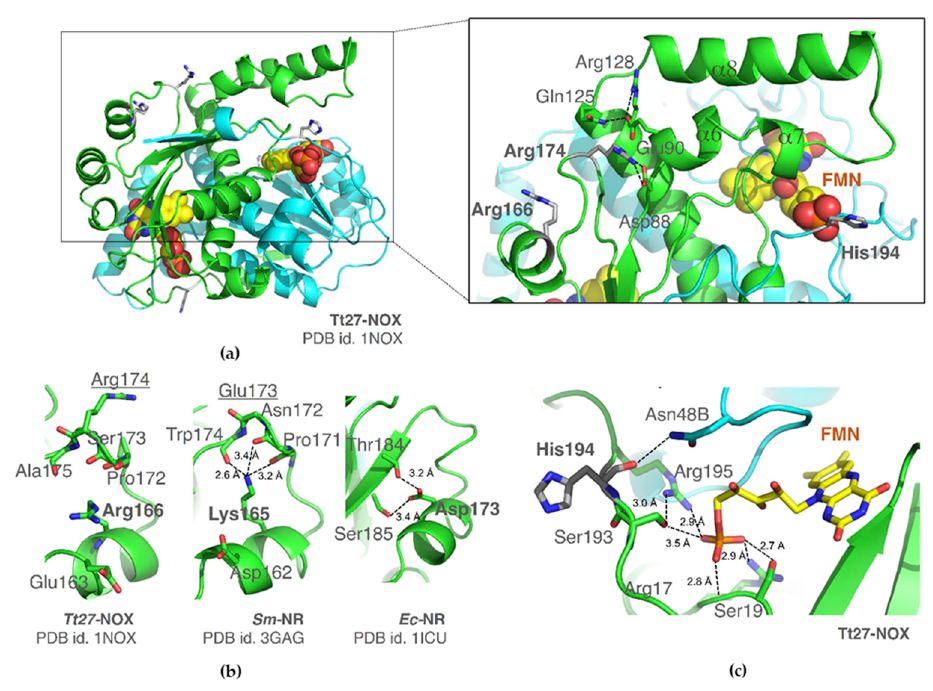
Figure 6. ( a ) NADH oxidase from Thermus thermophilus . The two monomers are shown in cartoon in green and in blue, respectively, and the three positions 166 / 174 / 194 are colored in grey. On the right hand side, it is shown in detail the mobile domain ( α 6– α 8) and the salt bridge network in which residue 174 (here, an Arg) is implicated. FMN is shown in spheres and colored in yellow. ( b ) Arg166 in Tt27-NOX, equivalent Lys165 in Sm -NR Mutants, and equivalent Asp173 in E. coli NR. ( c ) Detail of the oxanionic pocket to bind the phosphate group of FMN in Tt27-NOX. Residue His194 is in close proximity and its carbonyl oxygen is hydrogen bonded with the amide of the conserved Asn48B of the other subunit.